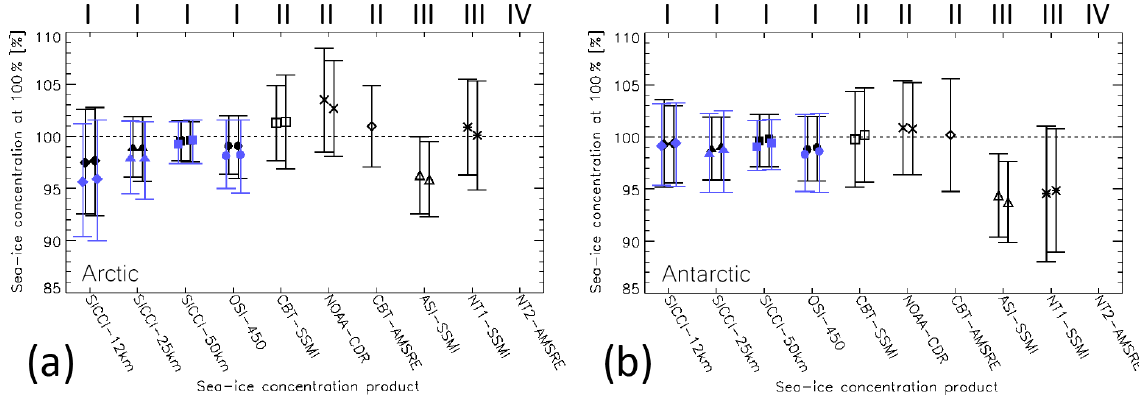
Figure 14. Summary of the results of the inter-comparison to the near-100% reference SIC (RRDP2) for (a) the Arctic and (b) the Antarctic. Shown for each sea-ice concentration product in black is the centre of the Gaussian fit of the sea-ice concentration ≤ 99% at the respective RRDP2 locations (see Fig. 4). Bars denote ± 1 standard deviation of the Gaussian fit. For symbol pairs (all products but CBT–AMSR-E and NT2–AMSR-E) the left symbol is based on data of the years 2007–2011 and the right one on data of the years 2007–2015. Blue symbols denote the mean non-truncated sea-ice concentration at the near-100% reference SIC for OSI-450 and SICCI products; blue bars denote the respective sea-ice concentration standard deviation. Roman numbers at the top denote product groups (see Table 2). No values are shown for NT2–AMSR-E because a Gaussian fit could not be adequately